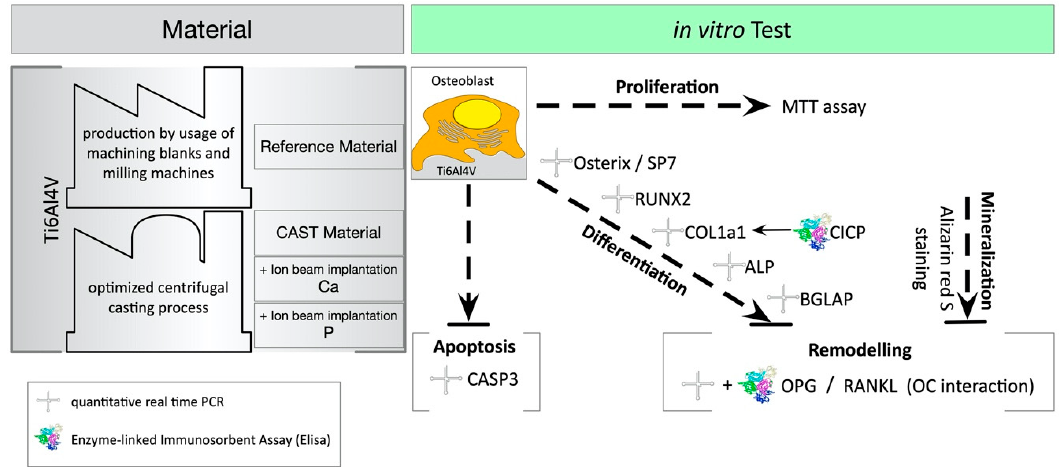
Figure 2. Scheme of the materials and methods used for in vitro testing. The medical grade alloy Ti6Al4V was processed under standard conditions (reference material; REF) or in the optimized centrifugal casting process (CAST). Some specimens were modified by ion beam insertion of Ca- or P-ions into the surface. Discs of 14 mm in diameter were seeded with human primary osteoblasts and underwent different in vitro testing. Cell biologic analysis focused on cell proliferation, osteogenic differentiation, matrix mineralization, remodeling processes, and apoptosis.